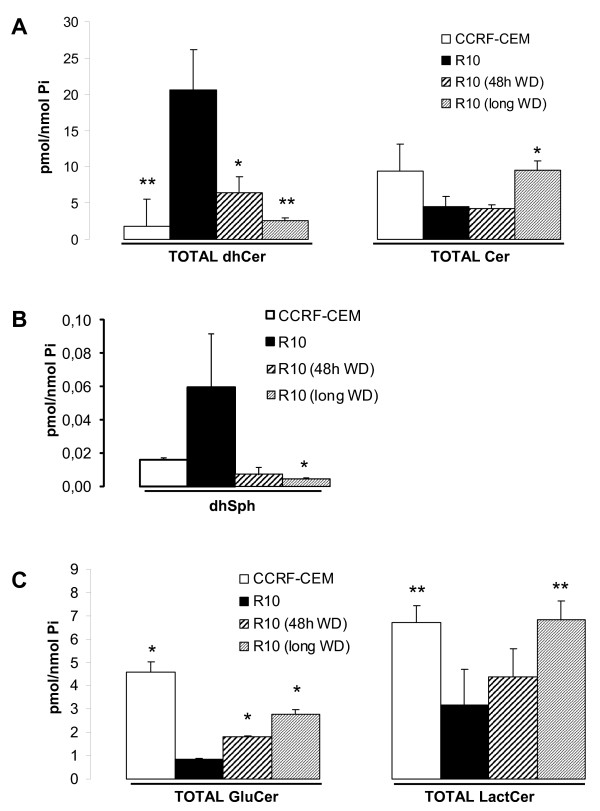
Comparative SL profile analysis upon drug withdrawal. R10 cells were incubated in 4-HPR-free medium for 48 h (WD = without drug) or long-term (~3 weeks) and endogenous SL profiles analyzed by LC-MS. Significance was based on R10 values. Data are average ± SD of 2-4 independent values. *P < 0.05; **P < 0.01; ANOVA plus Tamhane or Bonferroni post-hoc test.